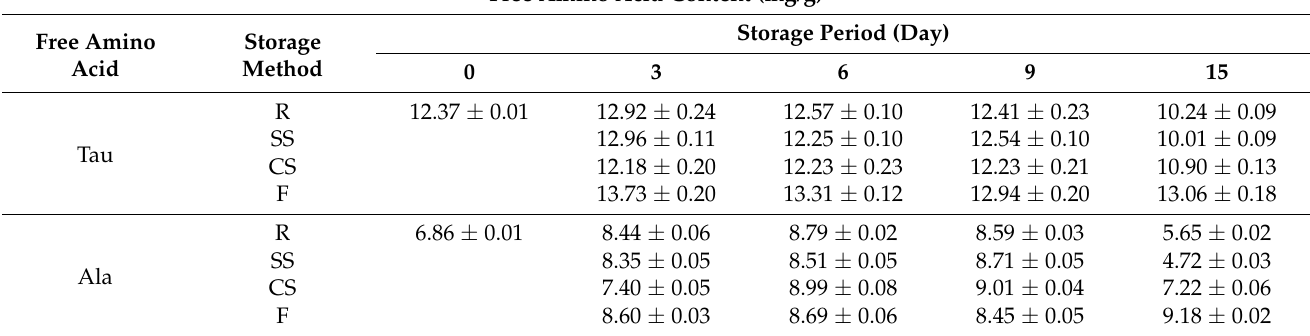
Table 1. Free amino acid content of raw laver ( Pyropia yenzoensis ) depending on various storage meth- ods (refrigeration, supercooling with stepwise cooling algorithm, constant temperature supercooling, and freezing) for 15